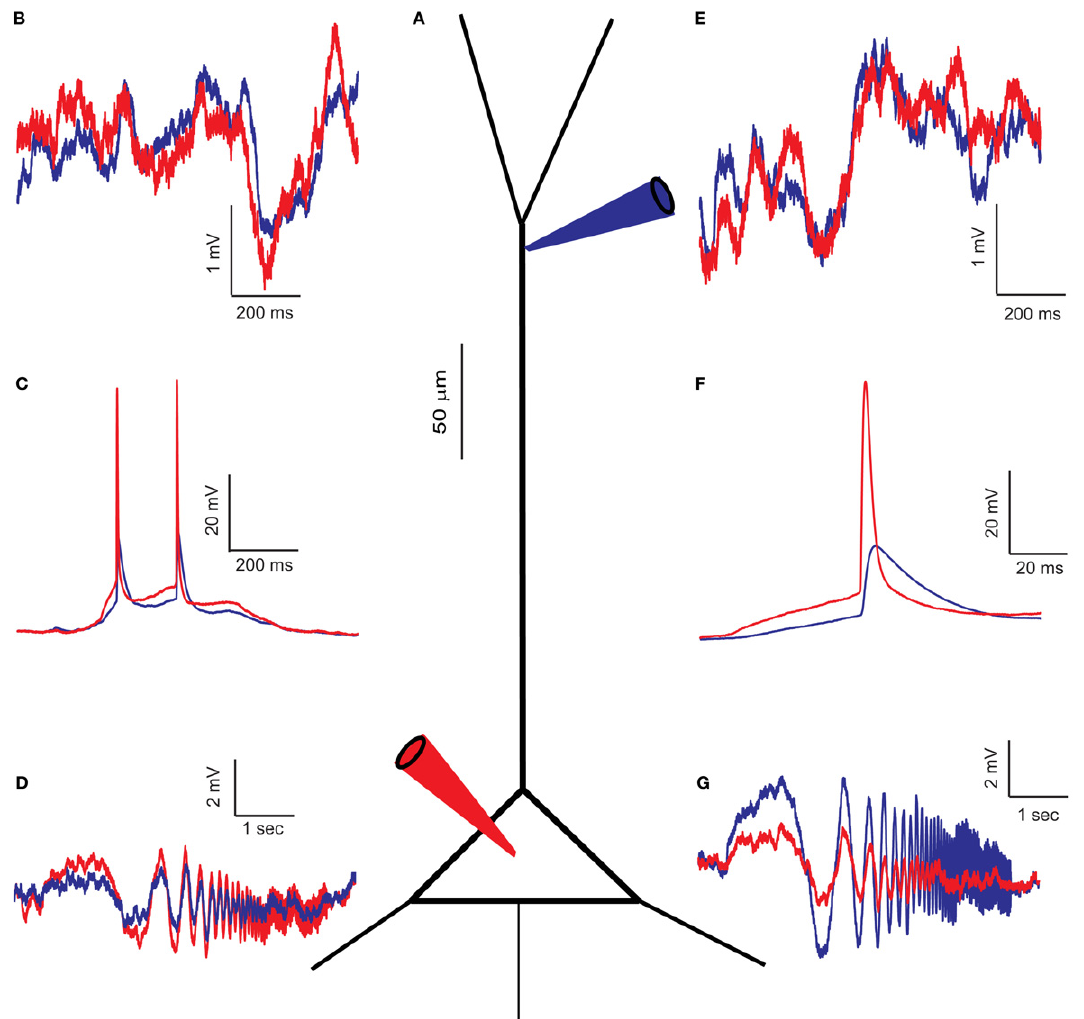
Figure 1 | Simultaneous recording from the soma and dendrite of a L4/5 pyramidal neuron in vitro . (A) Schematic drawing of a pyramidal cell with the two patch pipettes located at the soma (red) and at a distance of 250 μ m in the apical dendrite (blue). (B,E) Voltage noise recorded simultaneously from the soma (red) and dendrite (blue). Note that the noise is not identical at both locations, higher at times at the soma and at other times in the dendrite. (C) Superposition of two simultaneously recorded spontaneous action potentials recorded in the soma (red) and dendrite (blue). Note the attenuation of spike amplitude between the two recording sites. The difference in spike amplitude and shape confi rms that the recording electrodes were electrotonically separate. (F) Magnifi cation of the fi rst spike in (C) . (D,G) Voltage response at the soma (red) and dendrite (blue) to a ZAP current (see Materials and Methods) injected in the soma (D) and in the dendrite (G) . All measurements were made from the same